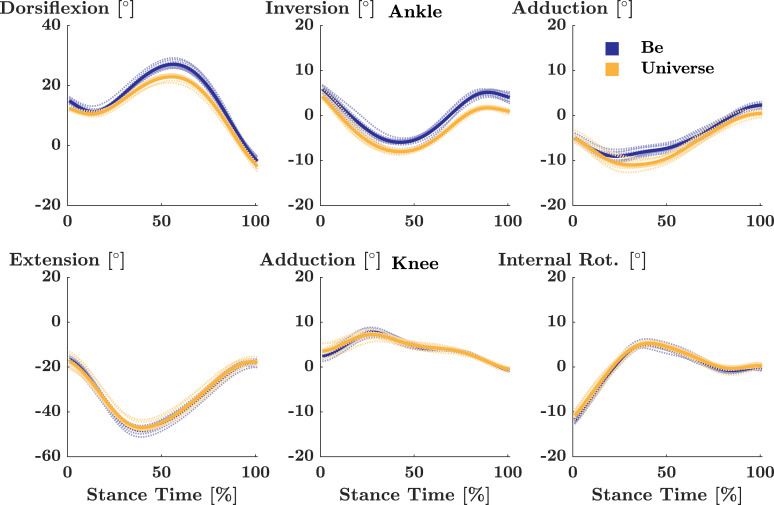
Exemplary ankle and knee joint kinematics in Be and Universe.Time normalized mean (solid) and individual (dotted) joint kinematics for the ankle (top) and knee (bottom) of a representative participant in be (blue) and universe (yellow).